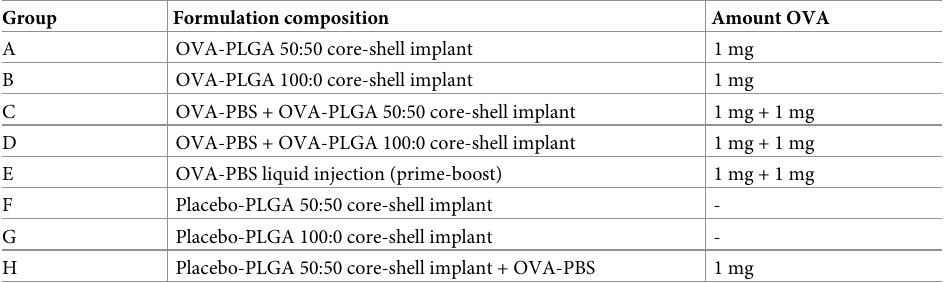
Table 1. Overview of the formulation composition used per group of mice immunized subcutaneously.